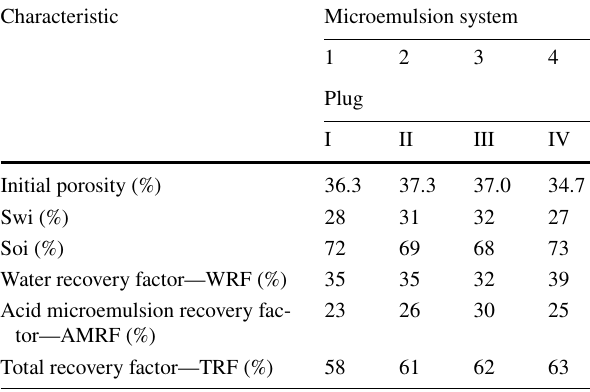
Fig. 6 Curves of pressure versus time for the dissolution reaction of calcium carbonate in acid systems and aqueous media Table 2 Results of recovery tests with acid microemulsion systems